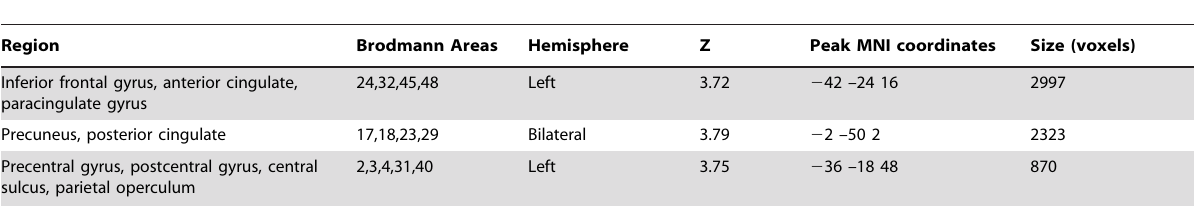
Table 1. Regions showing repetition suppression in both WM and Primed conditions (experiment 1).